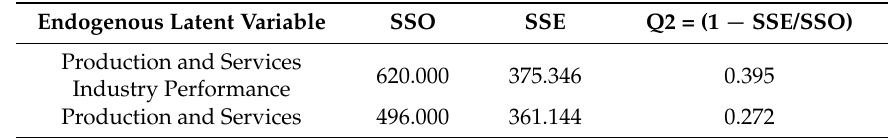
Table 6. Predictive relevance (Q 2 ).